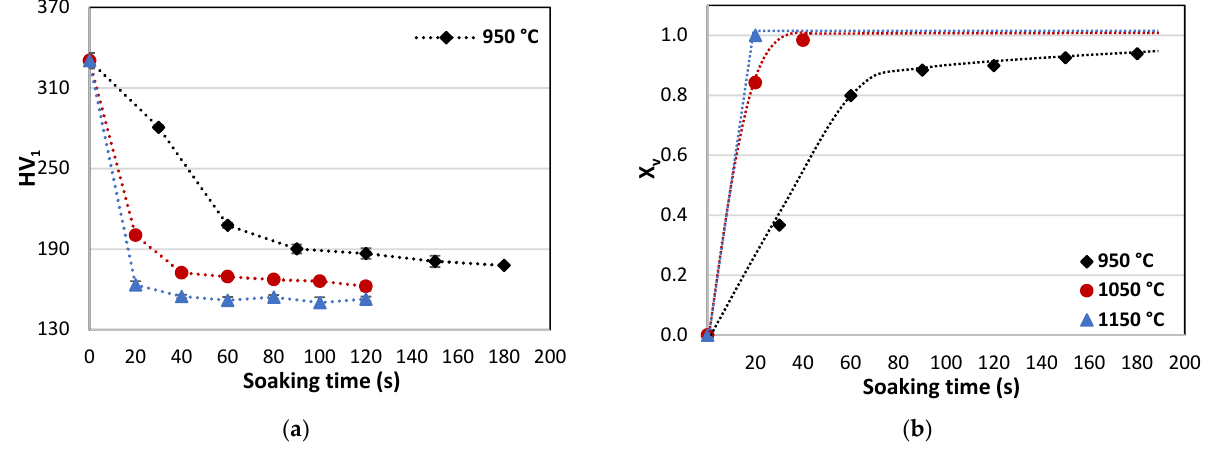
Figure 4. Effects of process parameters (temperature and soaking time) on hardness values (HV 1 )